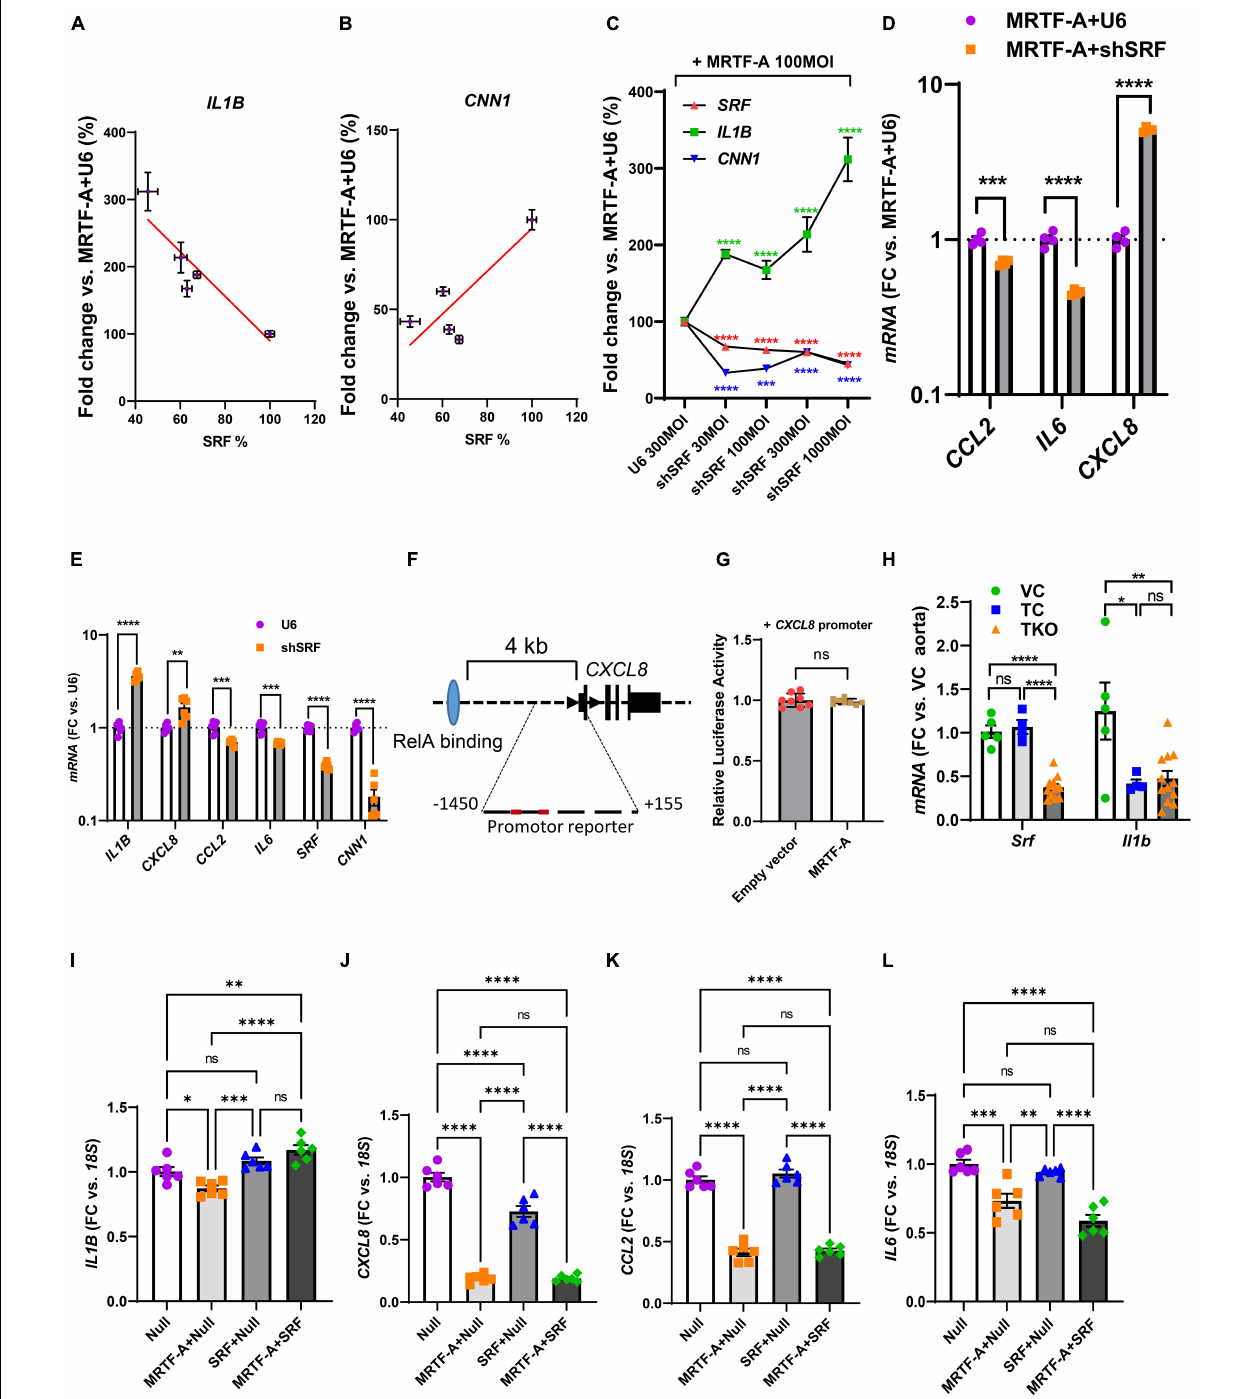
FIGURE 6 | SRF is important for regulation of IL1B and CXCL8 . (A–C) Human coronary SMCs were transduced with MRTF-A along with different titers of Ad-h-shSRF for knockdown of SRF. After harvesting the cells and isolation of RNA, SRF , IL1B , and CNN1 were assayed using RT-qPCR. In (A,B) , IL1B and CNN1 were plotted vs. the relative SRF level in the respective samples. In (C) , SRF , IL1B , and CNN1 were plotted vs. the titer (multiplicity of infection, MOI) of the short hairpin virus. (D) Shows the remainder of the inflammatory mediators in control vs. SRF-depleted cells (1000 MOI). (E) Is like (D) , except that SRF silencing was done without simultaneous overexpression of MRTF-A. (F) Shows the gene locus for human CXCL8 and binding of RelA (light blue oval) 4 kb upstream of the transcription start site. The proximal promoter contained two DNA sequences with two deviations each from the classical SRF-binding sequence. When testing this sequence in a reporter assay, no suppression by MRTF-A was however, seen (G) . In (H) , Srf and Il1b were assayed in the aorta from smooth muscle specific and inducible Srf